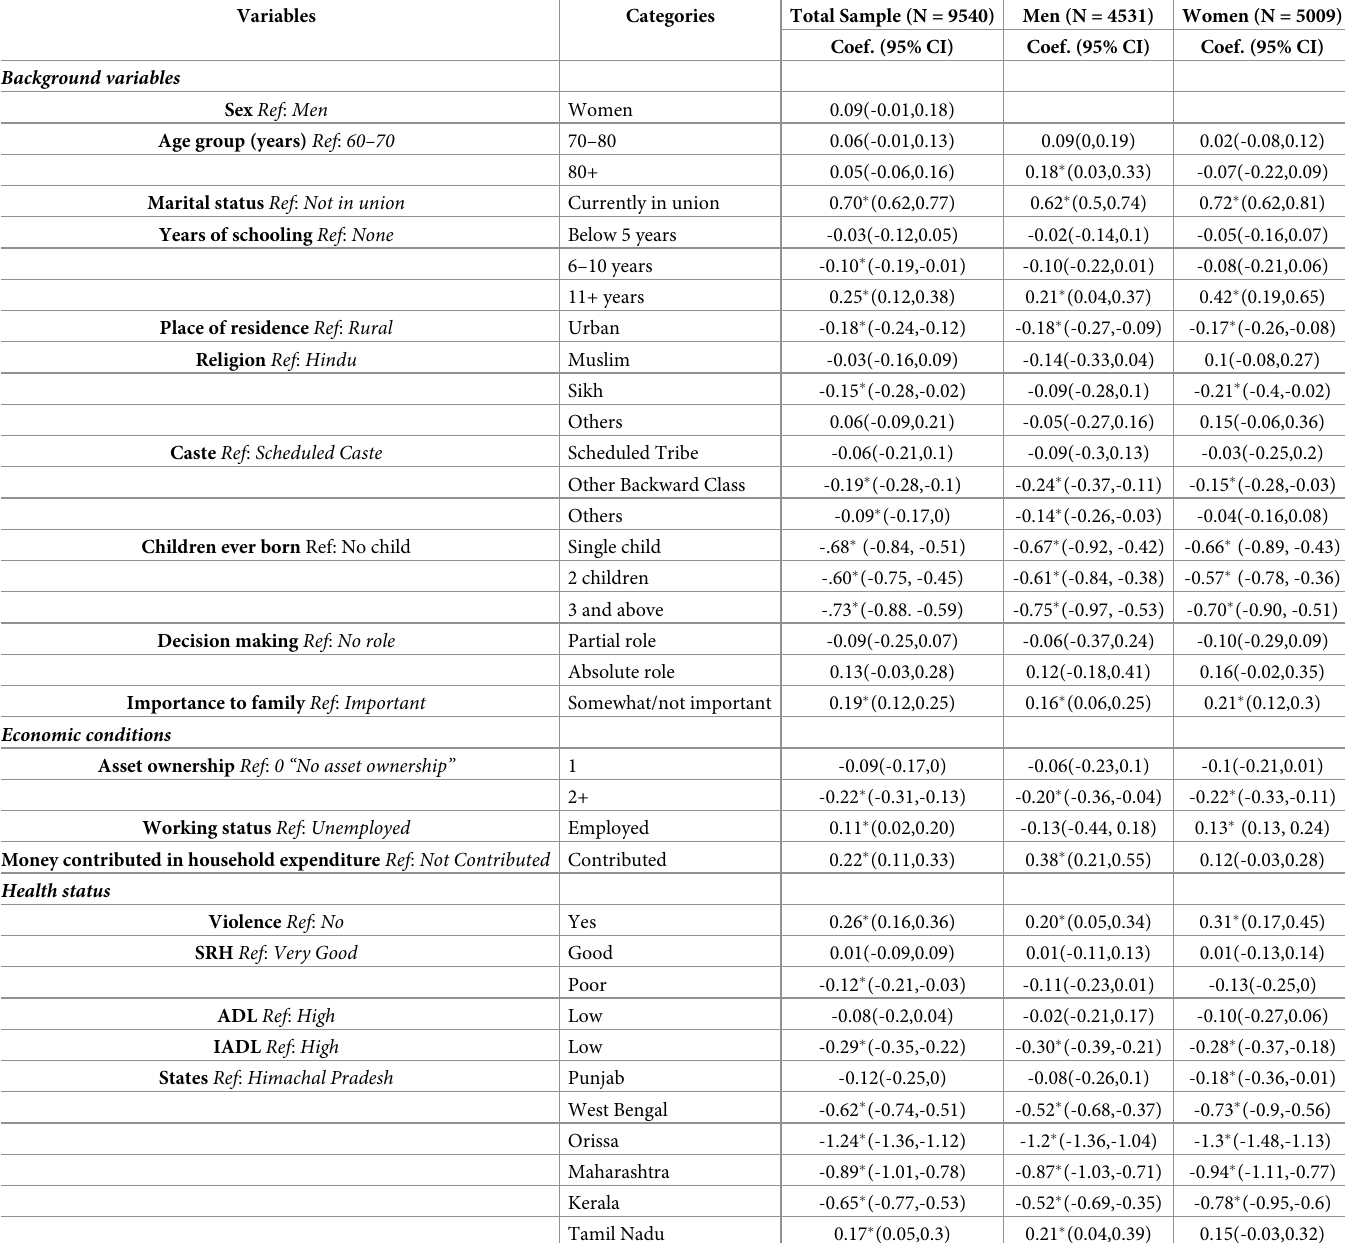
Table 3. Probit regression analysis for older adults preference over living in private by different background factors in